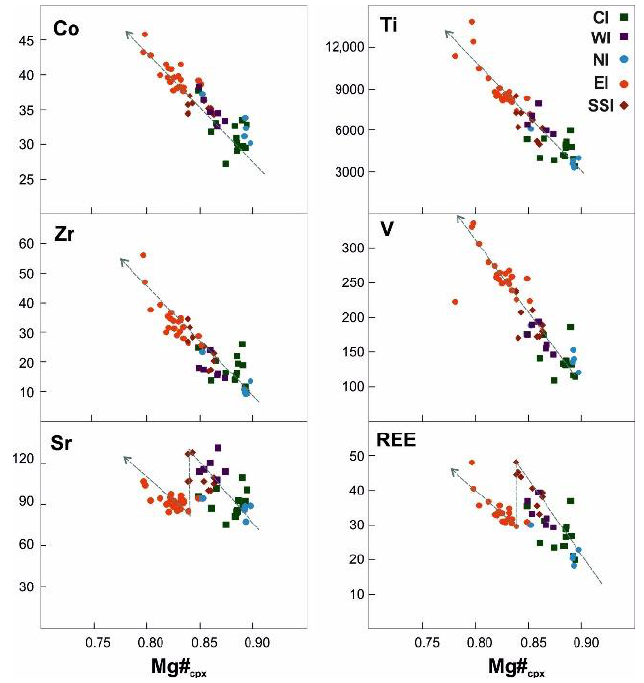
Figure 11. Diagrams of Mg# cpx vs. trace element compositions (ppm) for PN clinopyroxene relict cores (antecrysts). Incompatible trace elements present a clear negative correlation with Mg# cpx com- positions, suggesting an evolution trend compatible with that expected for fractional crystallization processes. In the case of PN, this antecryst evolution trend points to a deeper chamber evolution, before the formation of upper crust chamber. An inflection point is found for Sr and REE values